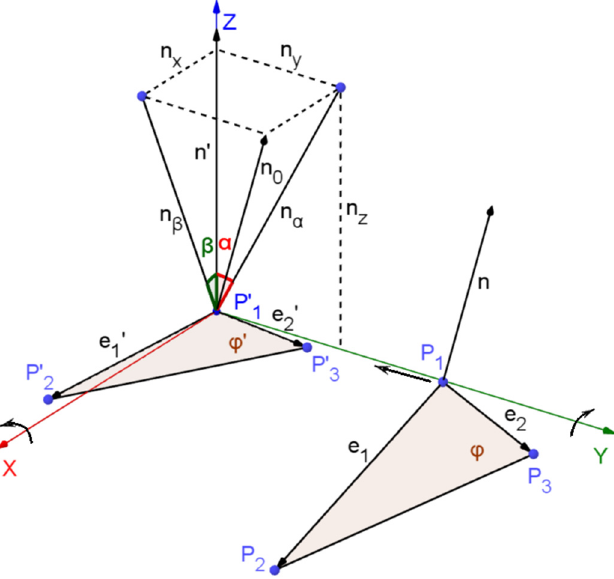
Fig. 8. Coordinate transformation of an arbitrary polyhedron